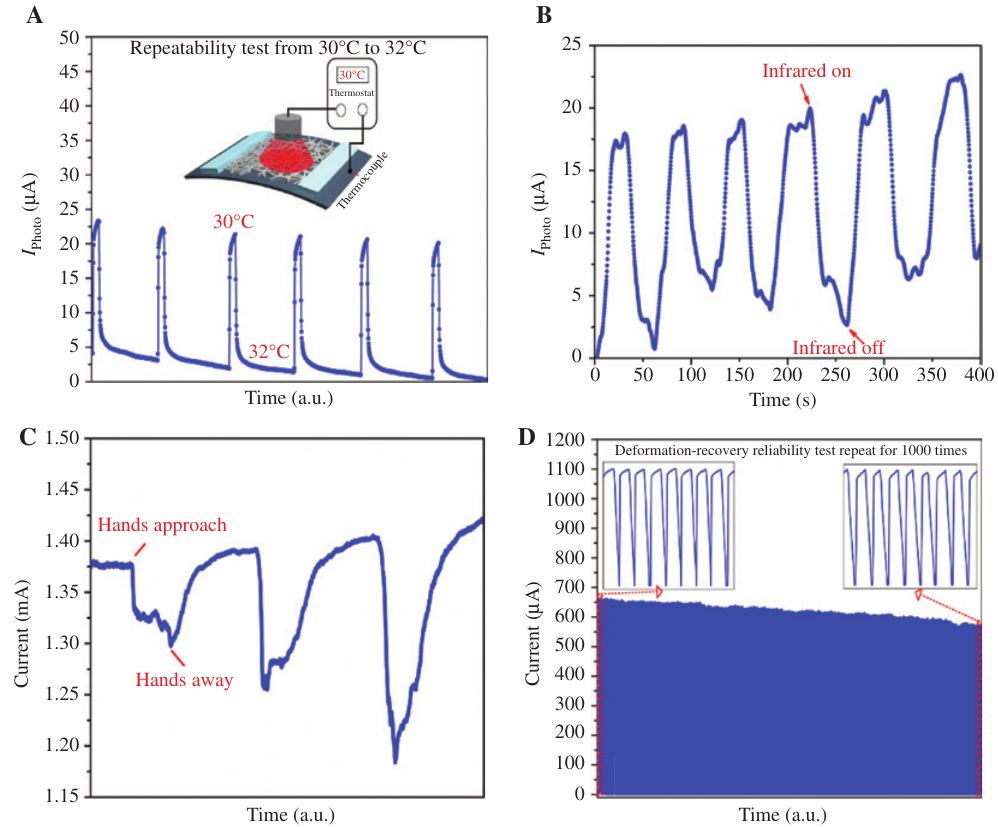
Figure 5: IR photothermal response of the GNW/PDMS device. (A) Response of the GNW/PDMS device under illumination of IR lamp with a temperature control. In this testing, the IR lamp turns on at 30 ° C and turns off at 32 ° C. (B) Response of the GNW/PDMS device under illumination of 980 nm light source. (C) Current changed with different thermal radiation (human body) of GNW/PDMS devices. (D) Performance of device with 1000 times bending test.